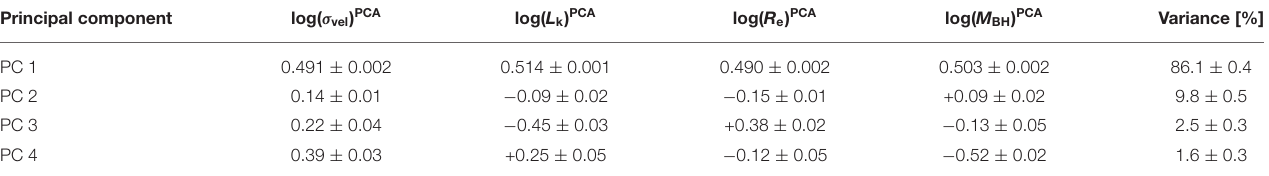
TABLE 2 | The coefficients and the variance of the principal components resulting from our 4D-space ( M BH - σ e - L - R e ) PCA are reported. Principal component